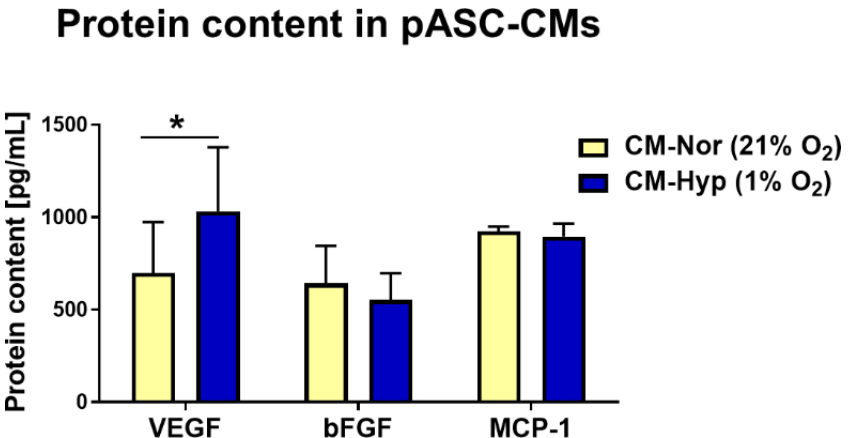
Figure 1. Bead-based quantification of protein levels secreted by pASCs cultured at 24 h in normoxia (21% O 2 ; yellow bars; n = 7) or hypoxia (1% O 2 ; blue bars; n = 7). Data are expressed as mean ± SD. * p < 0.05. Abbreviations: pASCs, pig adipose-derived stem cell; CM-Nor, conditioned medium collected from pASCs exposed to normoxia; CM-Hyp, conditioned medium collected from pASCs cultured under hypoxia.